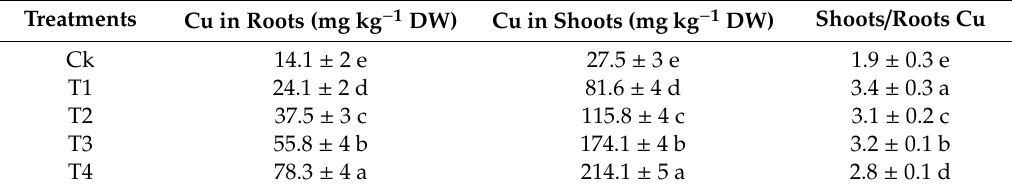
Table 2. Cu concentration in roots and shoots of C. capsularis grown under different concentration of Cu in the soil.